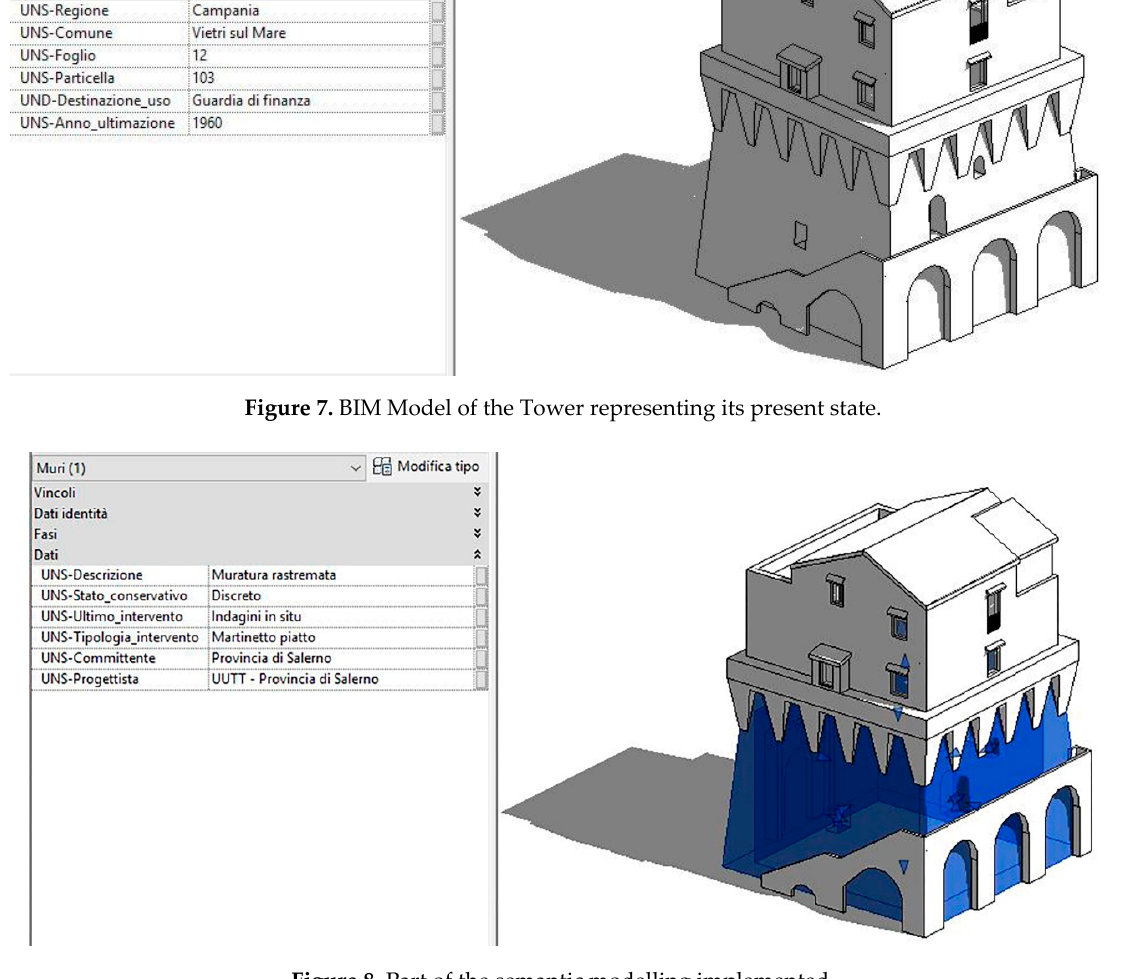
Figure 8. Part of the semantic modelling